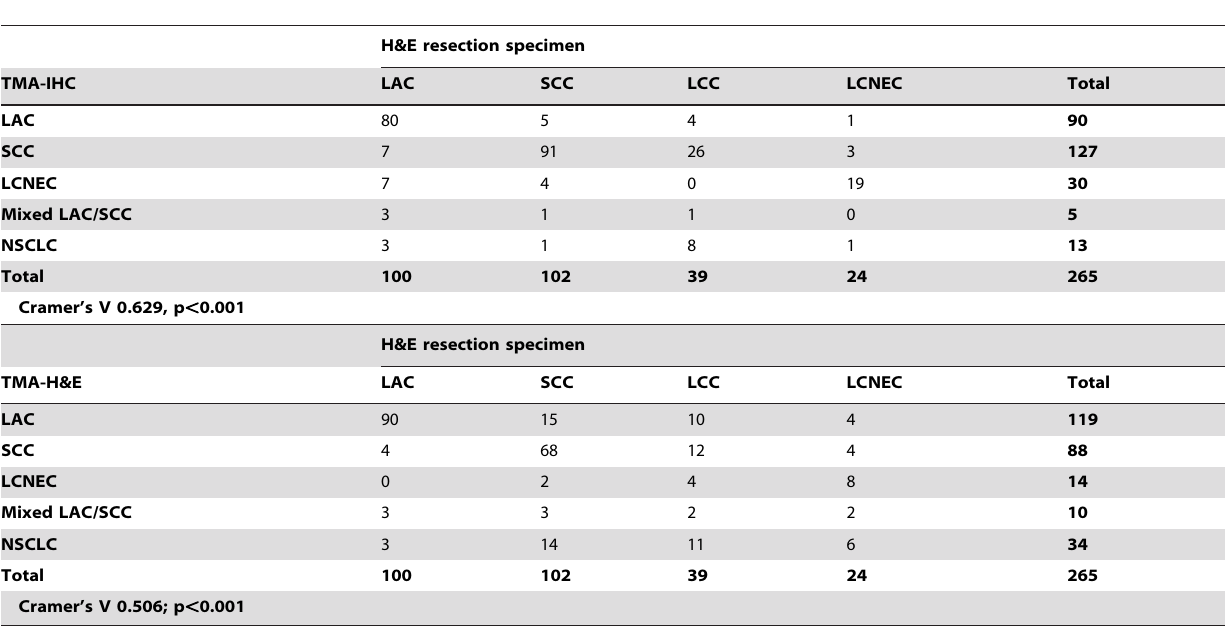
Table 3. Cross-tabulation for concordance or H&E-classification and IHC-classification with classification of resection